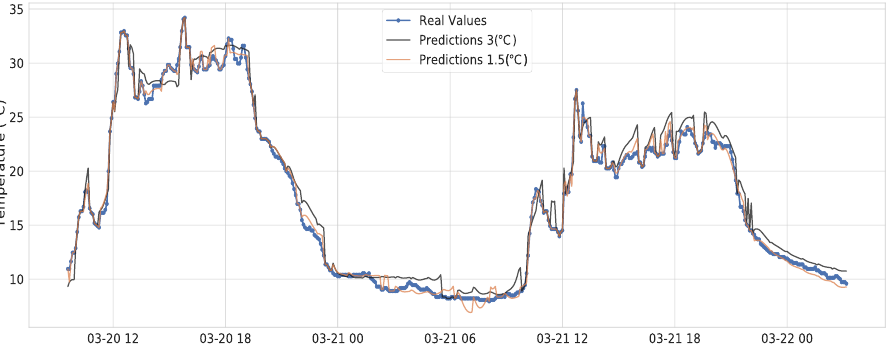
Figure 19. Forecast of temperature with different